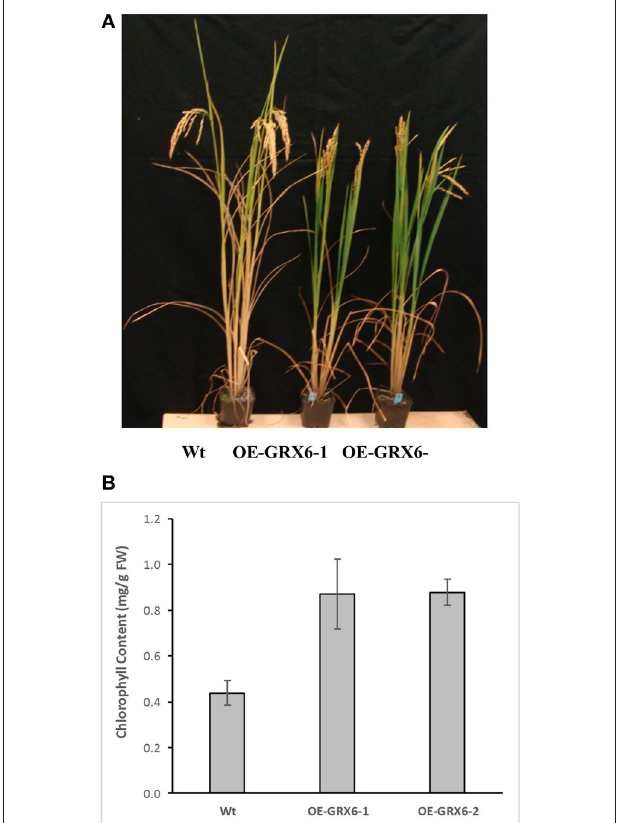
FIGURE 5 | Chlorophyll degradation in the wild type and transgenic rice lines overexpressed Os GRX6 gene (A) and total chlorophyll content of Wt and OE-GRX6-1 and OE-GRX6-2 (B), 16 weeks after planting. Data are means ± SD of 4 replicates, each replicate was collected from three different